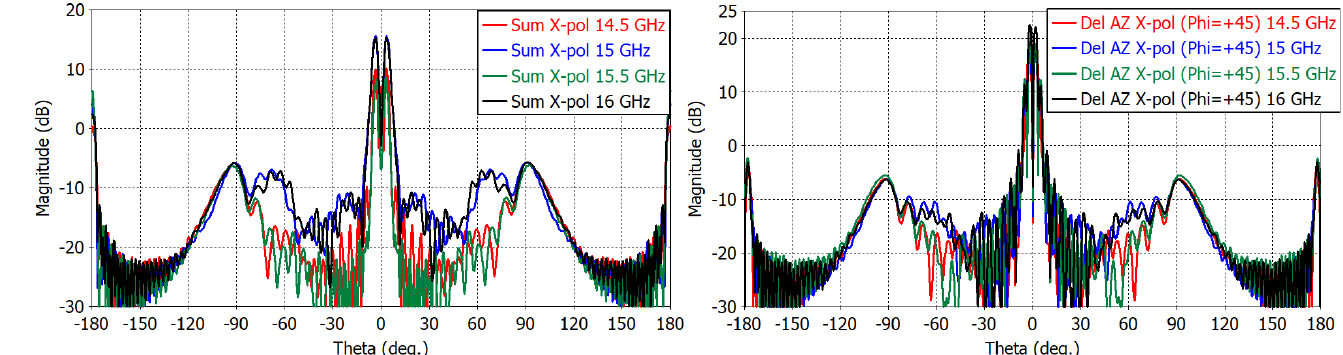
Figure 20. Cross-polarization directivity patterns of the reflector over ±180° angles.